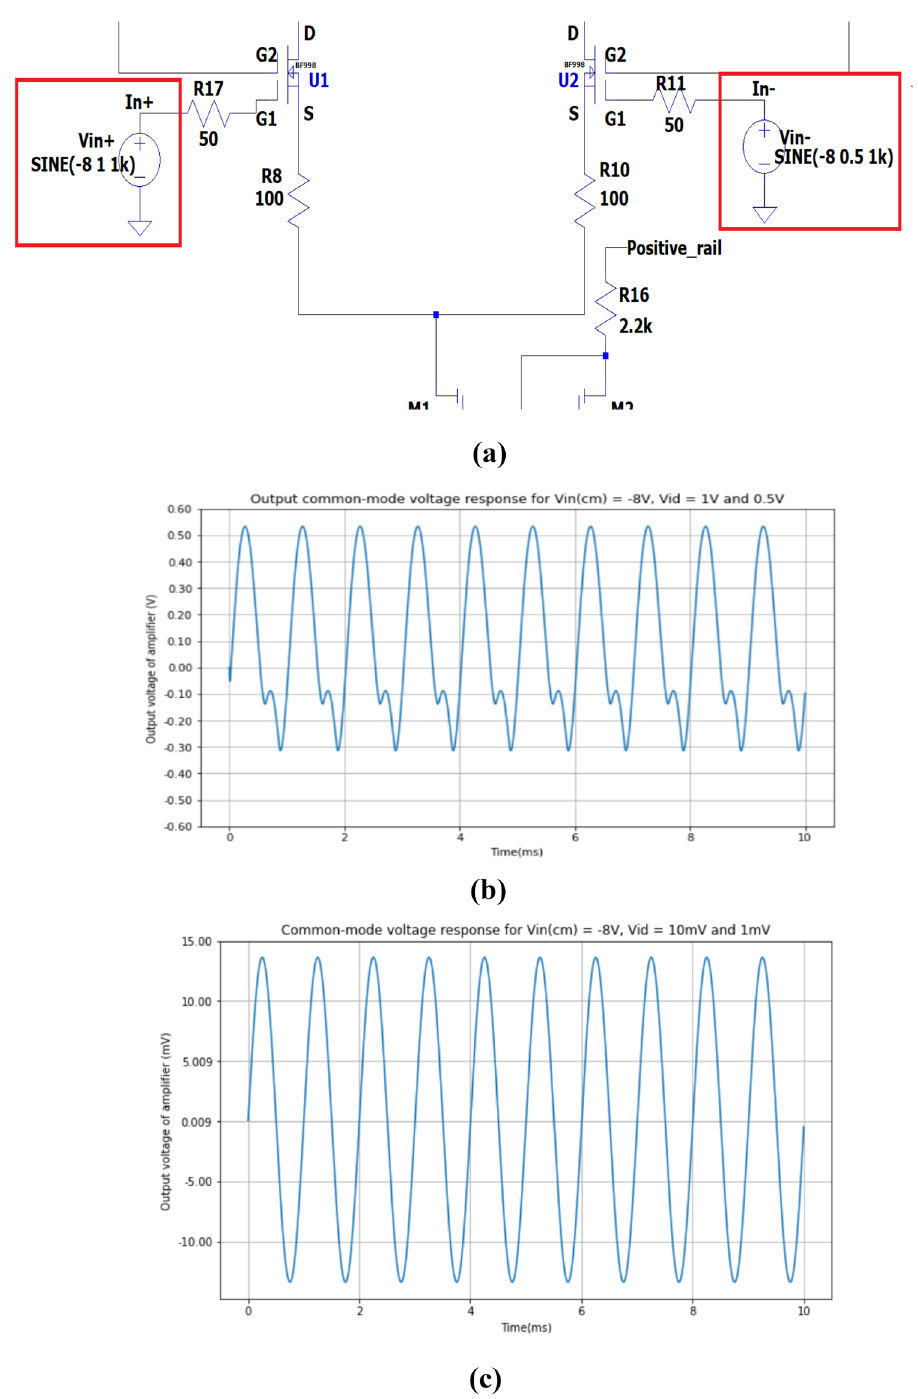
Fig. 12 a Excerpt of Fig. 6(a) showing test setup to inject signals to derive differ- ential gain for a signal of V = − 8 V . b Distortion at cm differential voltages of 1 V and 0.5 V , respectively for an input common-mode voltage of -8 V. c Distortion at differential voltages of 10 and 1 mV respectively for an input common-mode voltage of − 8 V. d Distortion at differential voltages of 1 V and 0.5 V respectively for an input common-mode voltage of 7 V. e Distortion at differ- ential voltages of 10 mV and 1 mV respectively for an input common-mode voltage of 7